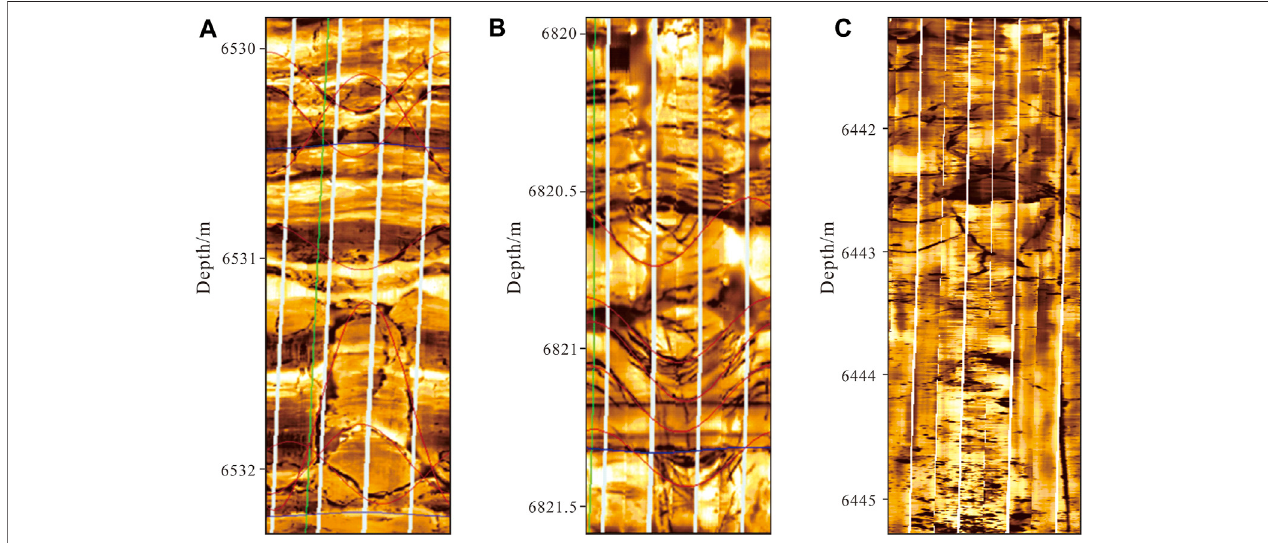
FIGURE 5 | (A) Well ks204, 6,530 ~ 6,532 m, network fractures; (B) Well ks803, 6,820 ~6,821.5 m, a group of parallel fractures; (C) Well ks24, 6,442 ~6,445 m, Several medium and low angle fractures.